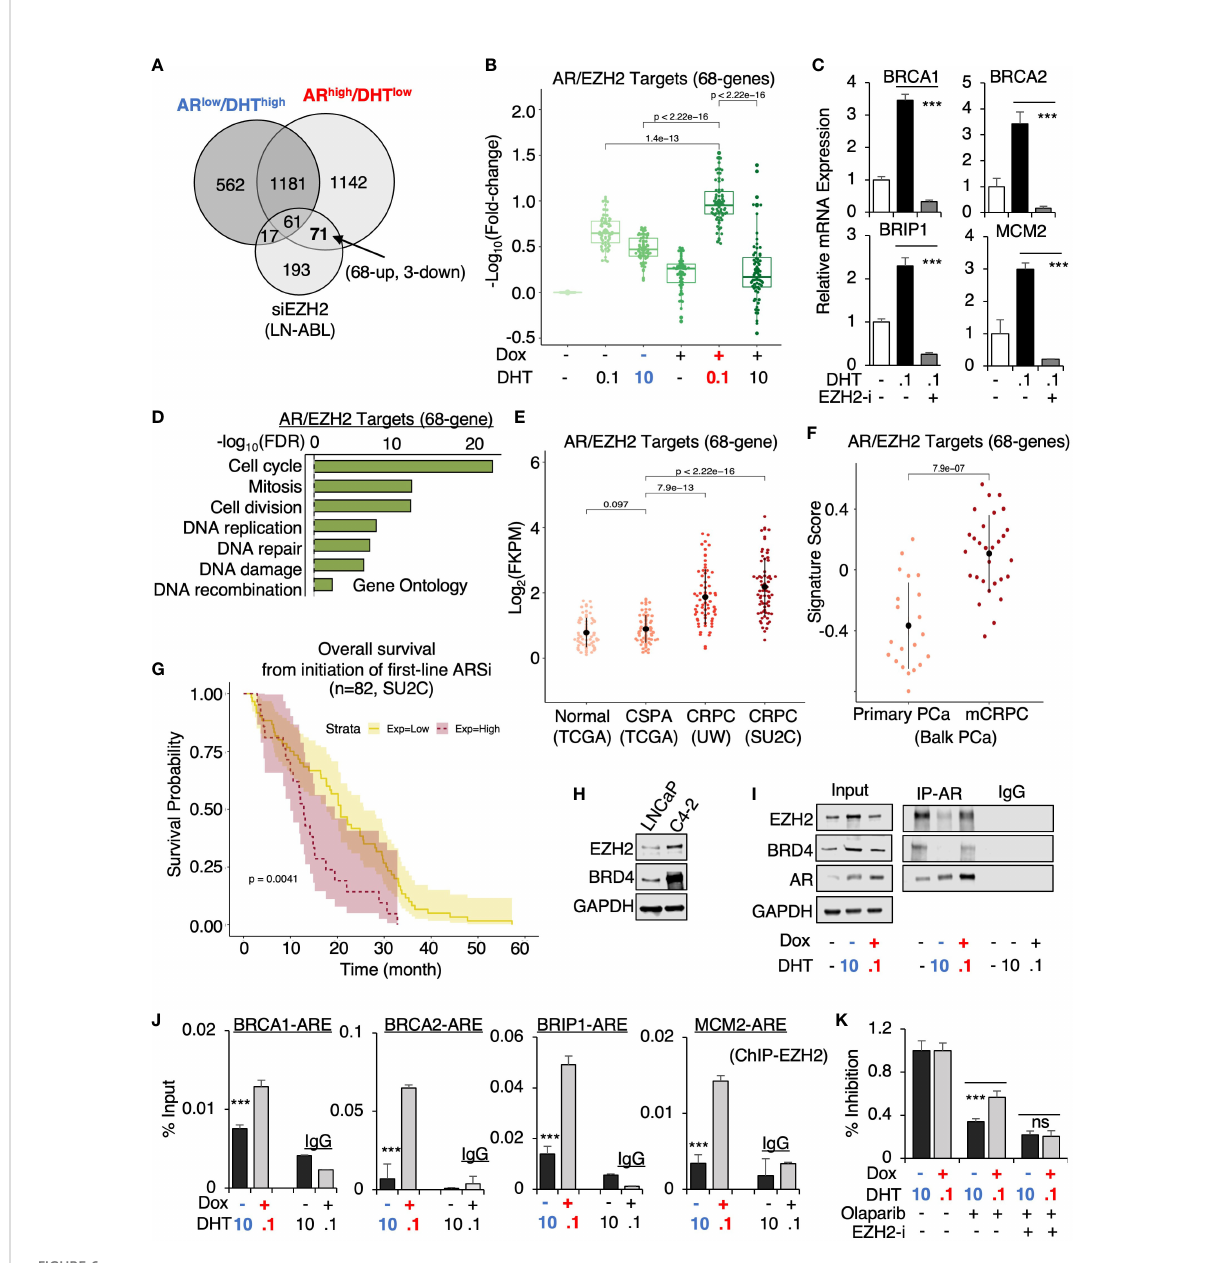
FIGURE 6 EZH2 is engaged in the reprogramming of AR in CRPC. (A) Venn diagram for DHT-regulated genes in AR low /DHT high and AR high /DHT low LNCaP- tet-AR cells and EZH2-regulated genes in LNCaP-ABL cells (fold-change > 1.5, adjusted P -value < 0.05). (B) Boxplot for AR/EZH2 co-target gene expression (68-genes) in LNCaP-tet-AR cells under indicated conditions. (C) qRT-PCR for AR high /DHT low -unique AR regulated genes treated with 0.1 nM DHT and an EZH2 inhibitor, GSK126 (50 m M for 24h). (D) Gene ontology of AR/EZH2 co-regulated 68 genes (FDR< 0.05). (E, F) AR/EZH2 co-target gene expression (68-gene) in TCGA, UW, and SU2C datasets (E) and Balk PCa dataset (F) . (G) Kaplan-Meier survival analysis for the overall survival from the initiation of the fi rst-line ARSi in mCRPC patients (SU2C cohort) with higher scores (purple, top 25%) of AR/EZH2 target signatures versus the lower scores (yellow, bottom 75%). (H) Immunoblotting for indicated proteins in LNCaP versus LNCaP-C4- 2 cells. (I) Immunoblotting for indicated proteins in LNCaP-tet-AR cells immunoprecipitated with AR. (J) ChIP-qPCR of EZH2 at indicated AR binding sites. (K) Cell growth inhibition for LNCaP-tet-AR cells under the indicated conditions and treated with 30µM olaparib for 2d, or olaparib plus GSK126 (50 µM for